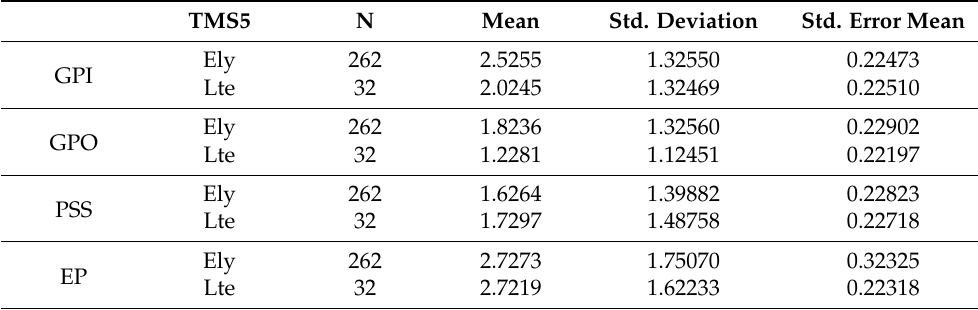
Table 2. Group statistics for estimation of non-response